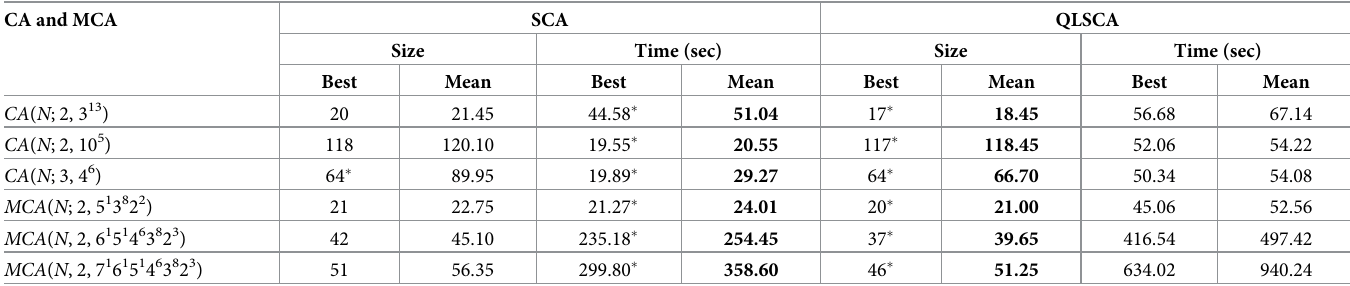
Table 3. Time and size performances for SCA and QLSCA.